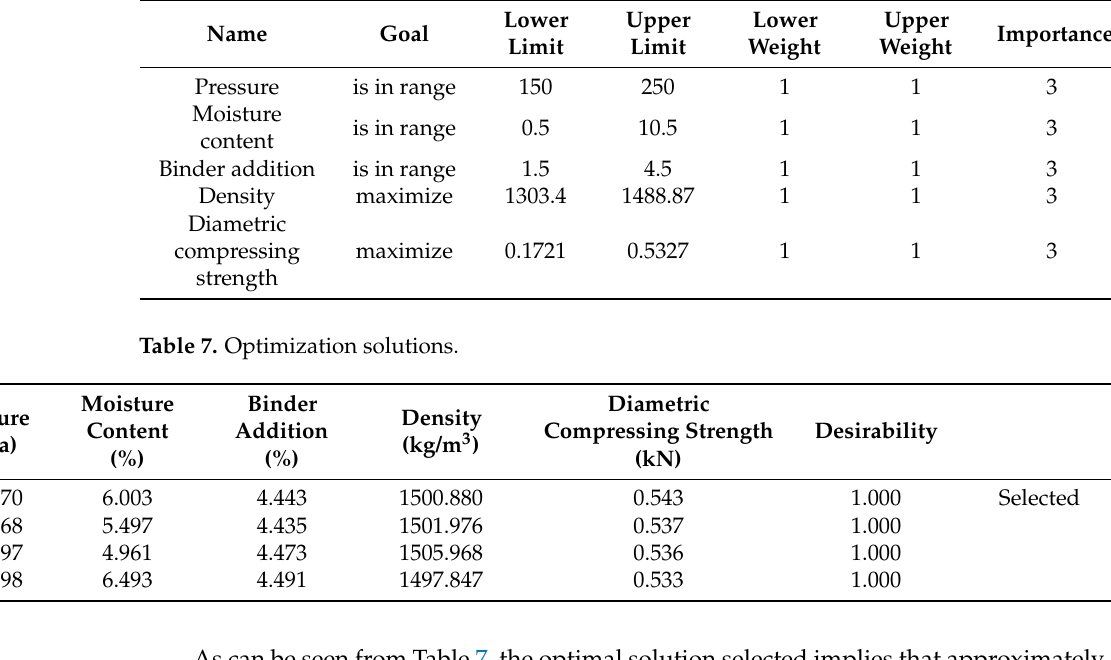
Table 6. Constraints for optimization experiments.